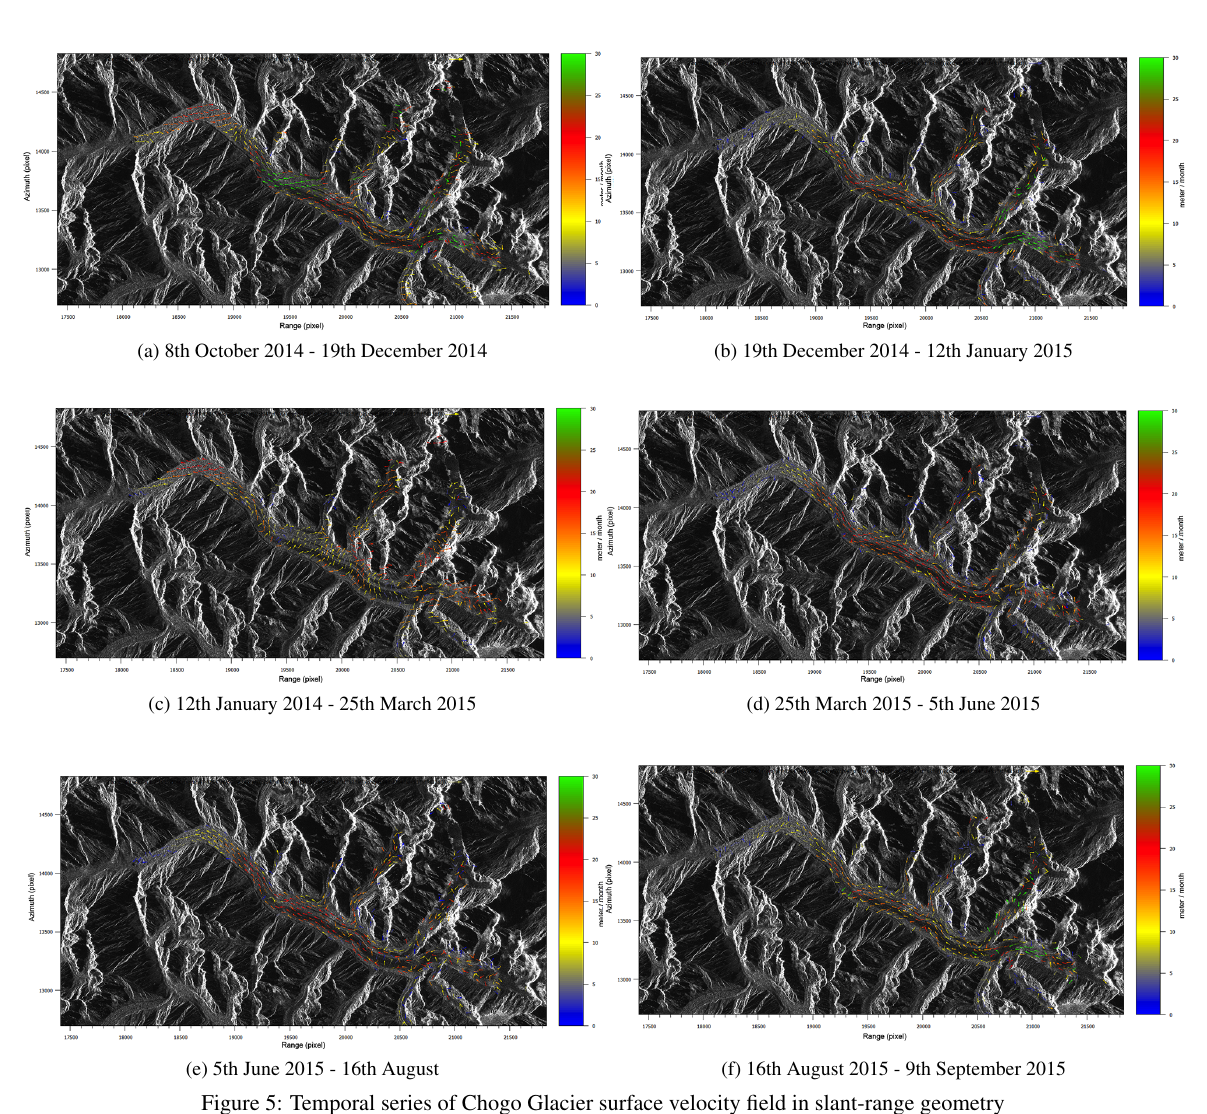
Figure 5: Temporal series of Chogo Glacier surface velocity field in slant-range geometry